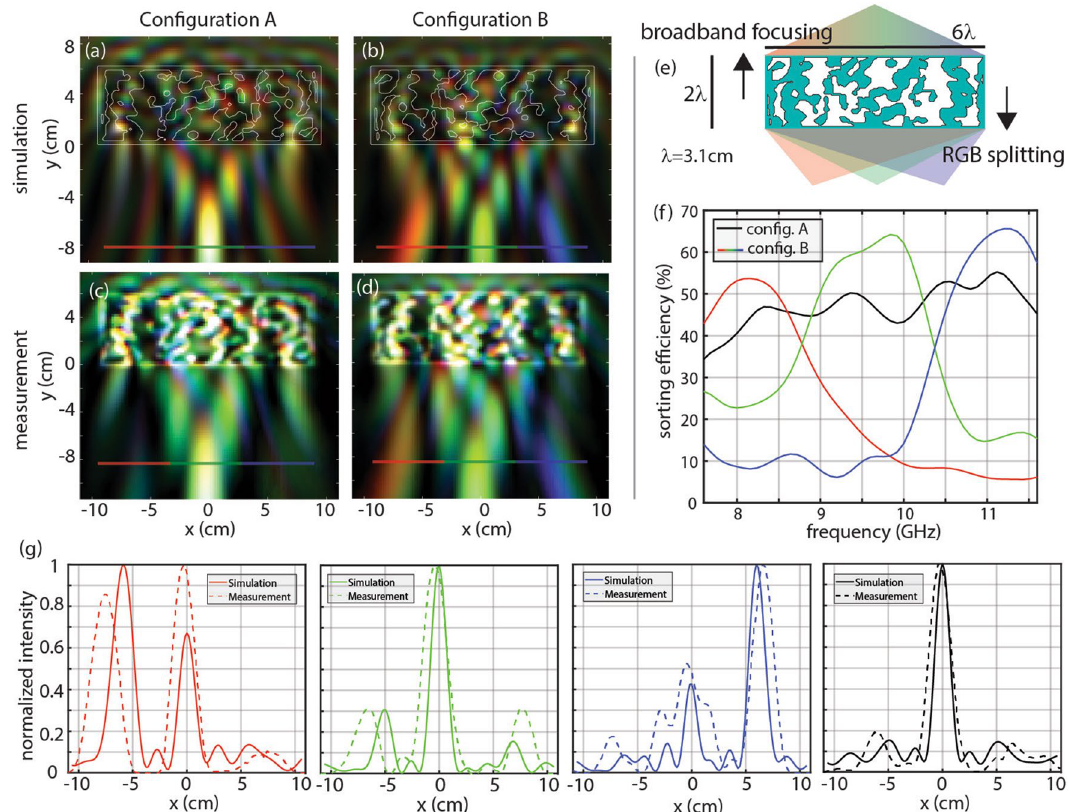
Figure 2. Rotatable device performing broadband focusing in one configuration and spectral splitting in the other configuration. ( a ) Broadband focusing simulation, ( b ) spectral splitting simulation, ( c ) broadband focusing measurement, and ( d ) spectral splitting measurement. ( e ) Schematic of the device, where blue represents PLA and white represents air. The footprint of the device is 6.2 cm × 18.6 cm. ( f ) Analysis of the simulated fields at the focal plane showing the sorting efficiency for each function, defined as the fraction of incident power reaching the target pixel. Red, green, and blue light are focused to their respectively colored pixels, and sorting efficiency is drawn in red, green, and blue, respectively. The broadband focusing function focuses all light to the middle pixel and is drawn in black. ( g ) Comparison of simulated and measurement normalized intensity profiles at the focal plane. Configuration B intensities are integrated over (left) 7.6– 8.9 GHz, (center-left) 8.9–10.2 GHz, (center-right) 10.2–11.6 GHz. (right) Configuration A intensity integrated from 7.6 to 11.6